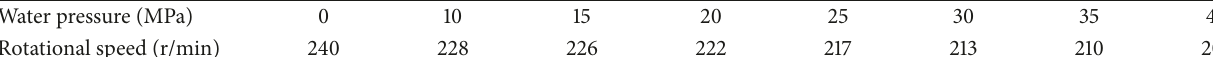
Table 2: Relationship between rotational speed and water pressure.